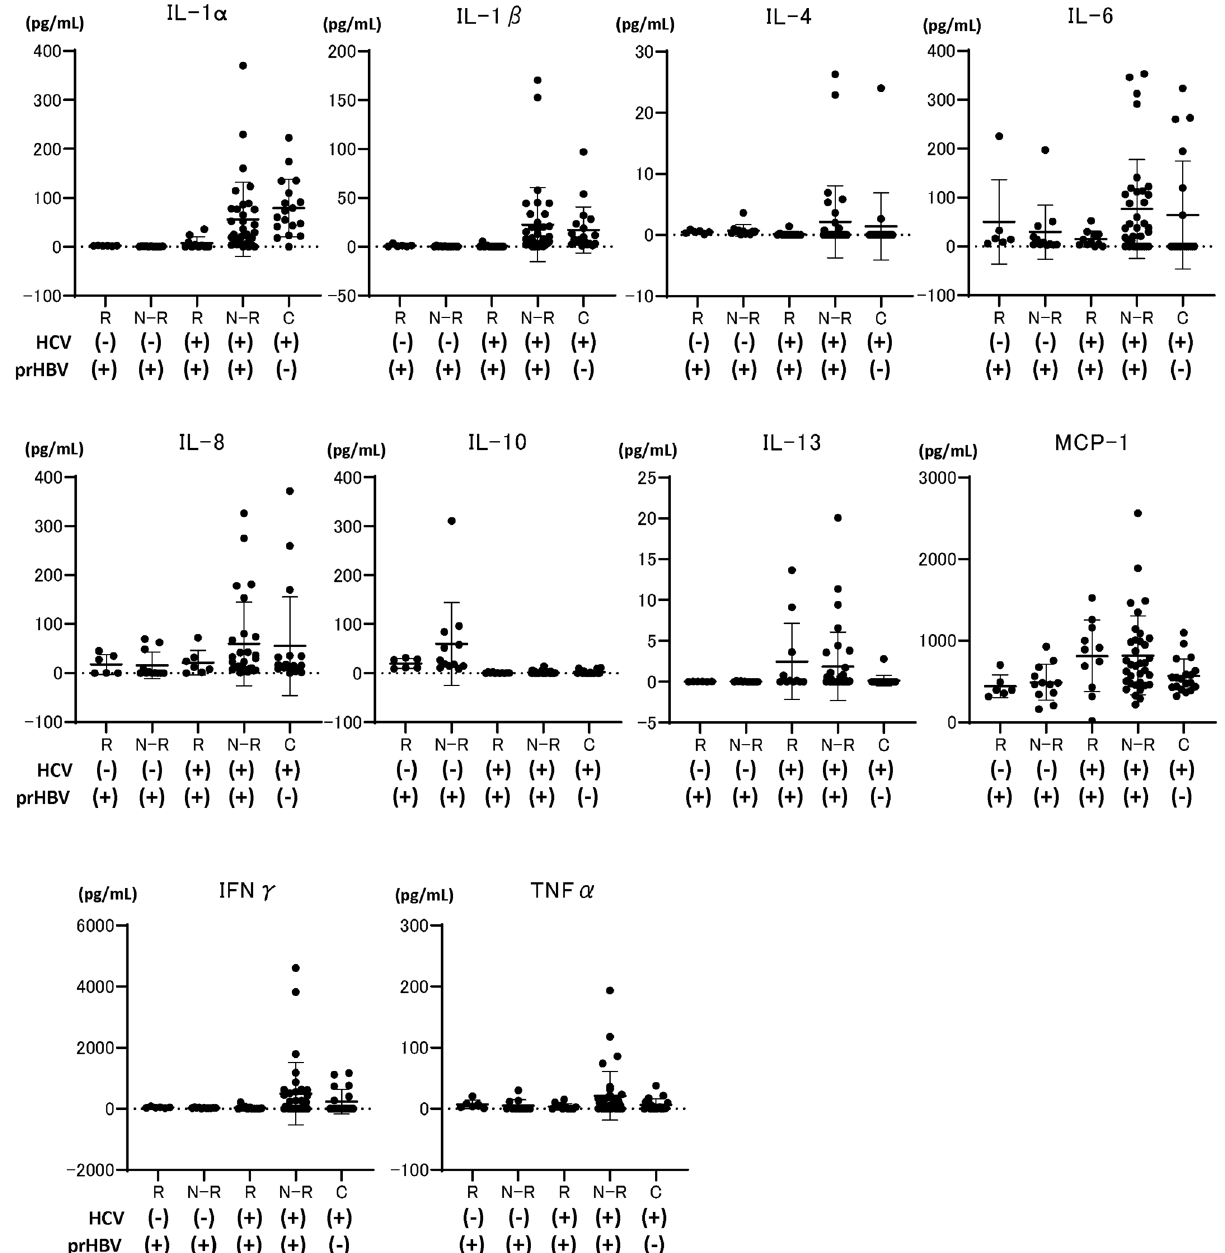
Figure 6. Comparison of baseline cytokine levels among patients classified according to the presence of HCV infection, existence of previous HBV infection, and presence of HBV reactivation during DAA, anti-cancer/ immunosuppressive therapy, or bone marrow transplantation. Each data are shown as median ± SD. *P < 0.05, **P < 0.01. HCV hepatitis C virus, HBV hepatitis B virus, DAA direct-acting antiviral, IL interleukin, MCP monocyte chemotactic protein, IFN interferon, TNF tumor necrosis factor, SD standard deviation, R HBV reactivation, N-R non-HBV reactivation, C HCV control without previous HBV infection, prHBV previously resolved HBV